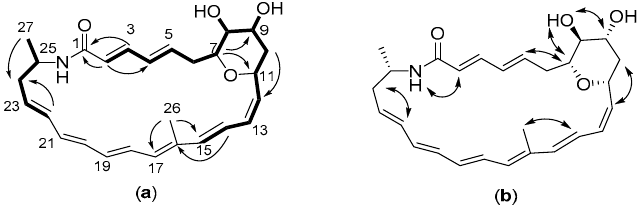
Figure 3. ( a ) 1 H- 1 H COSY and key HMBC correlations of pretilactam ( 1 ). ( b ) Key NOESY correlations of pretilactam ( 1 ).